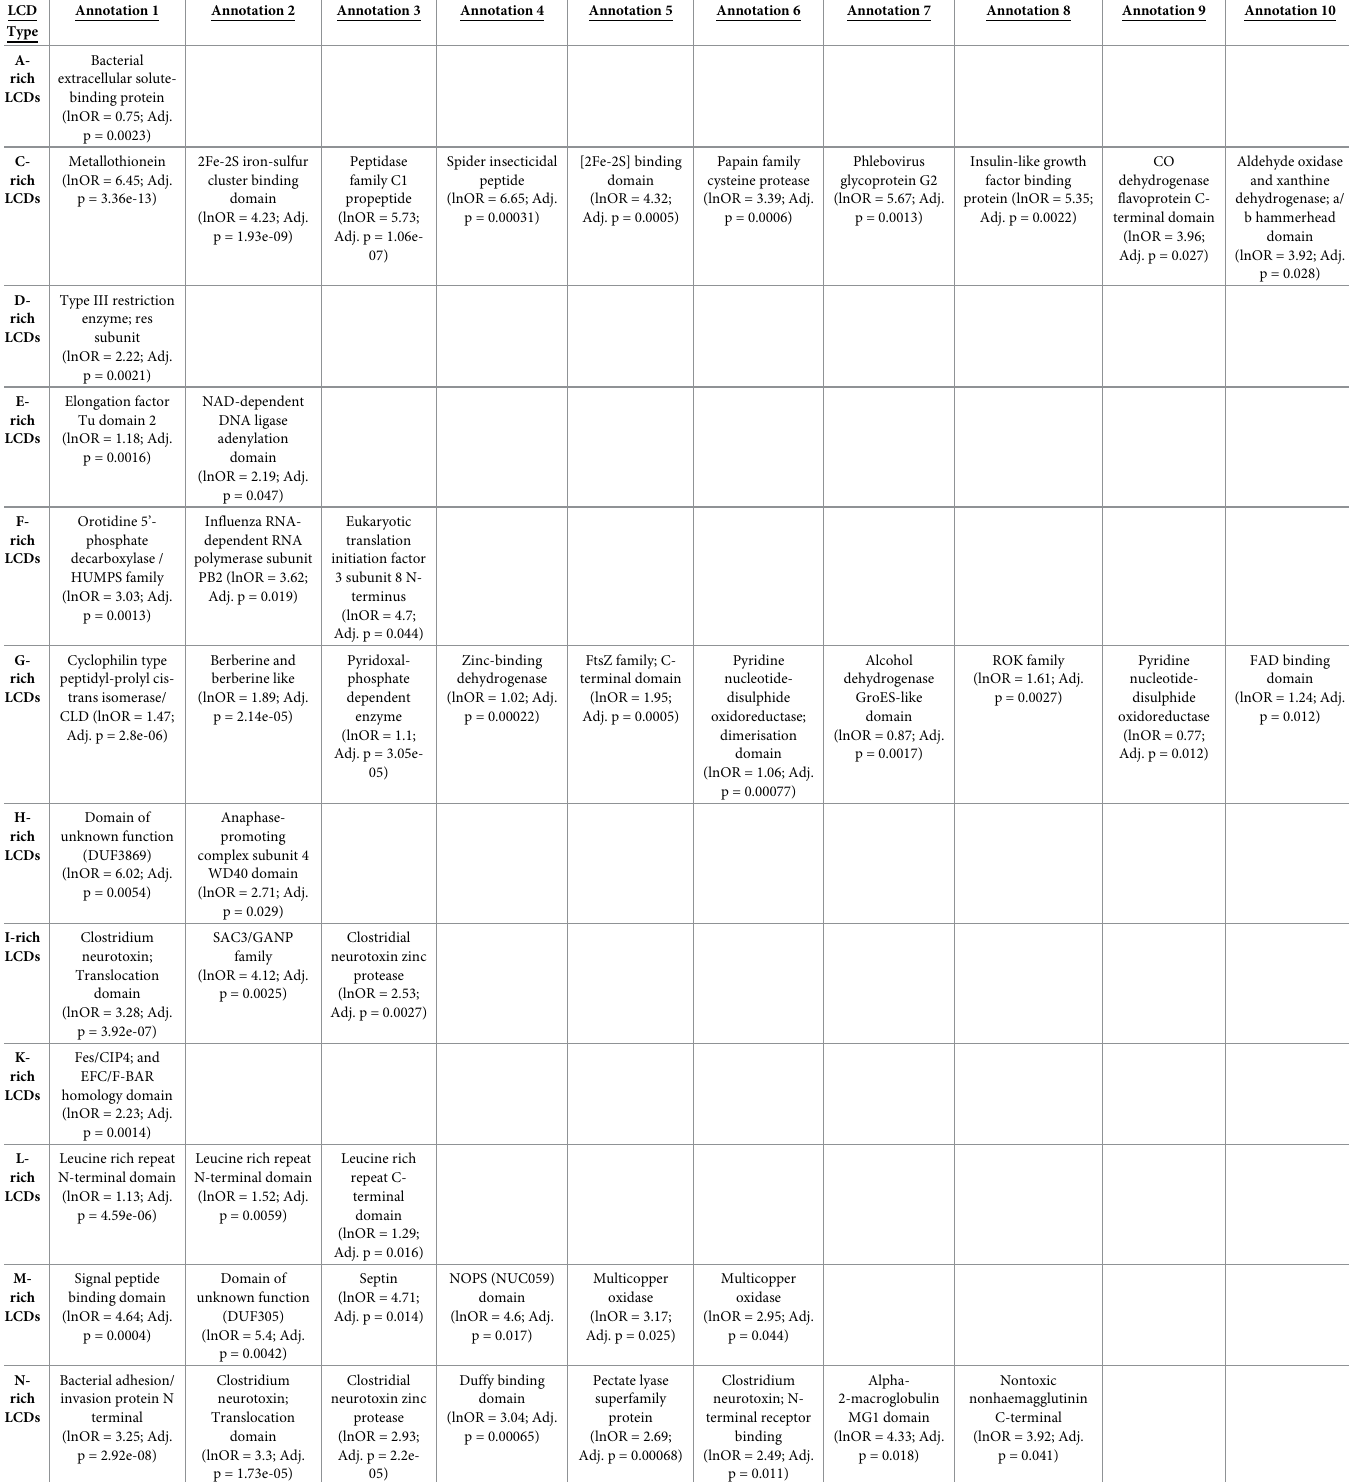
Table 1. Top 10 significantly enriched Pfam annotations associated with each LCD category. For each LCD class, up to 10 significantly enriched (lnOR > 0.0) Pfam annotations are indicated in ascending order according to Holm-Sˇida´k corrected p -value. LCD